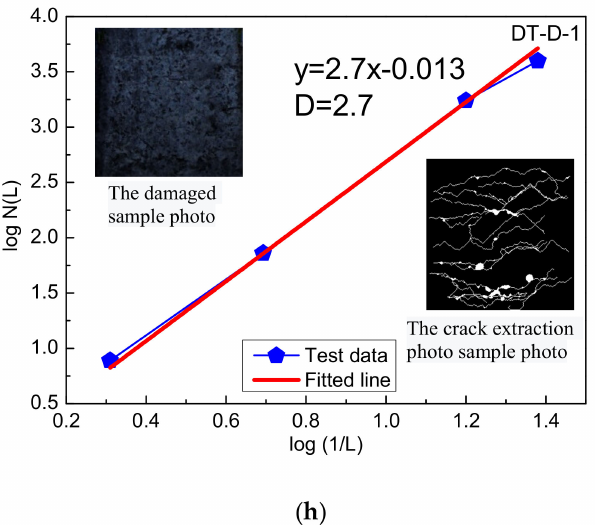
Figure 9. The fractal characteristics of rock damage at different loadings: ( a , c , e , g ) starting time of period-doubling bifurcation state of sample; ( b , d , f , h ) starting time of chaotic state of